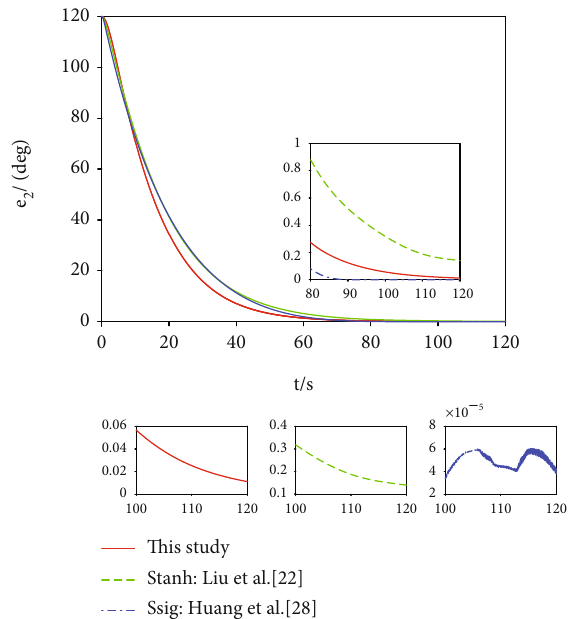
Figure 11: Relative attitude error